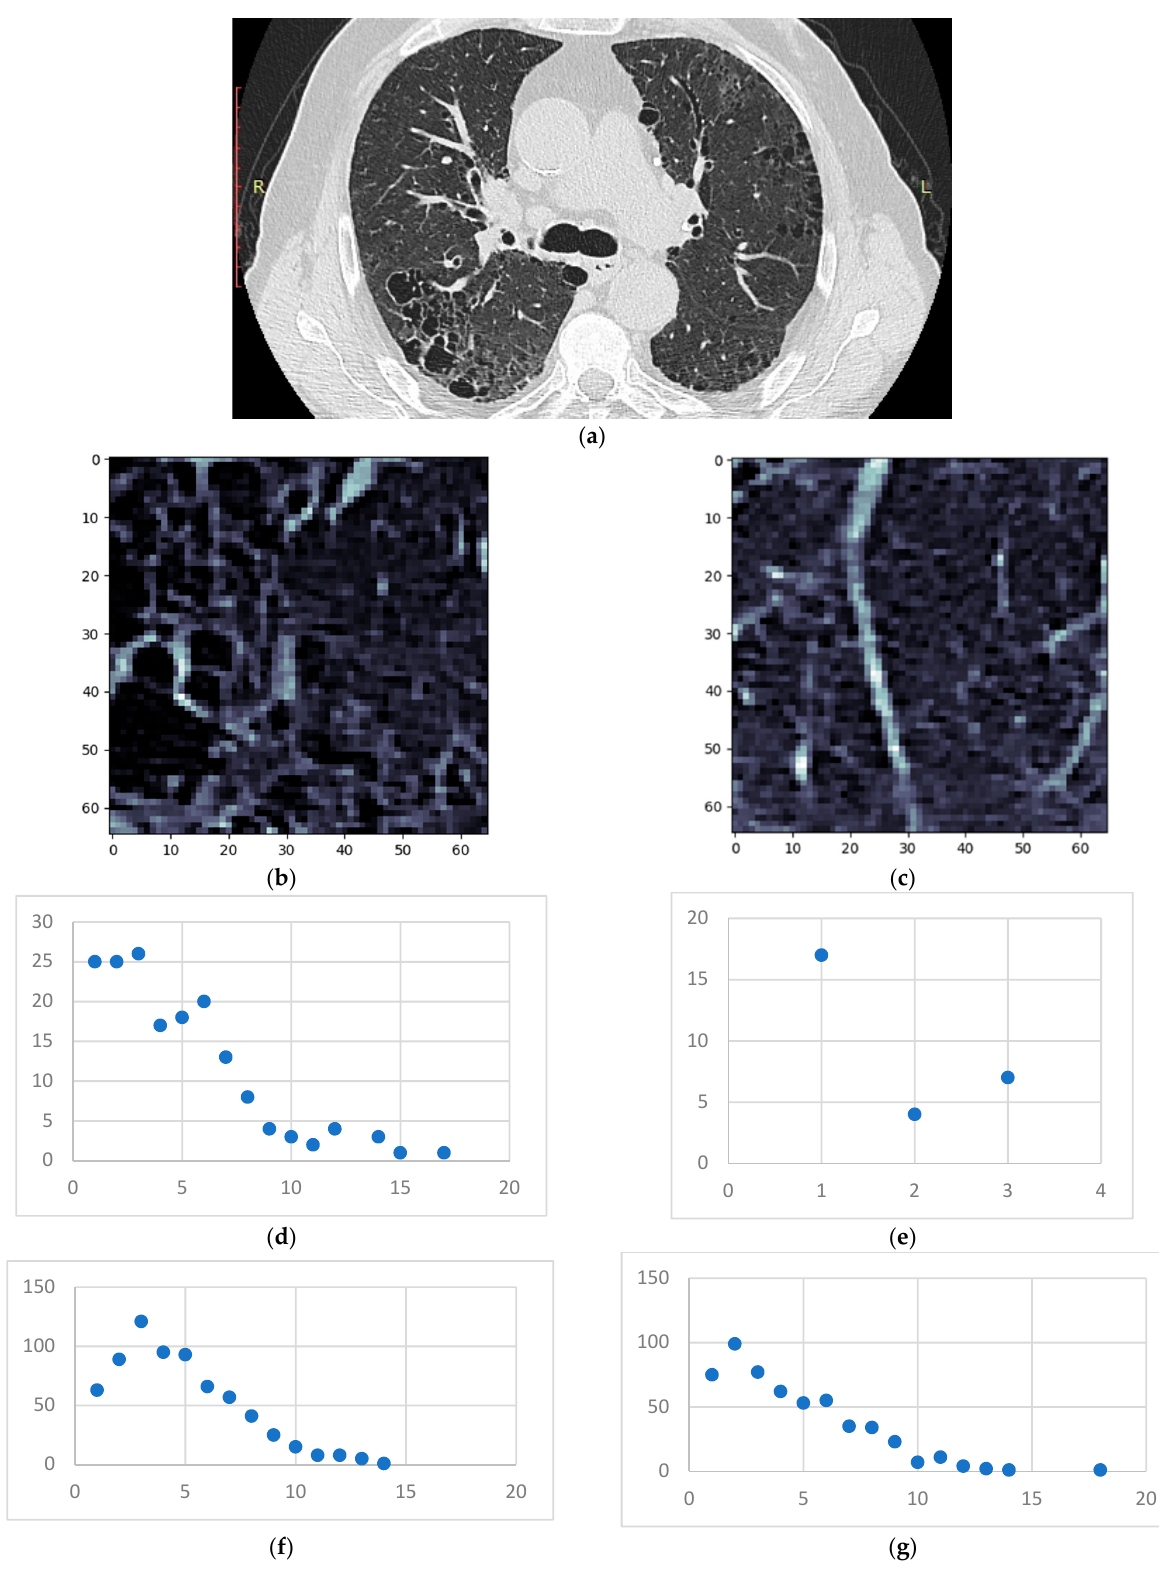
Figure 12. ( a ) HRCT slice under analysis ( b ) Sample 1 ( c ) Sample 2 ( d ) Degree distribution for sample 1 on the emphysema layer ( e ) Degree distribution for sample 2 on the emphysema layer ( f ) Degree distribution for sample 1 on the GGO layer ( g ) Degree distribution for sample 2 on the GGO layer.